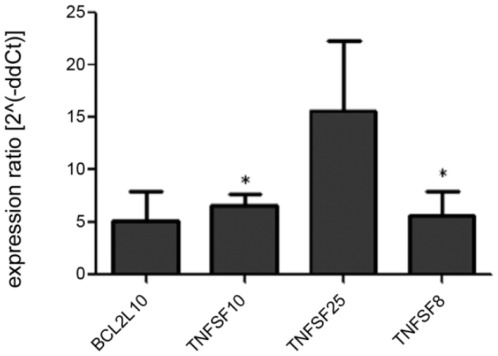
RNAi of DPP3 (siDPP3) inhibits influenza replication by modulation of apoptotic genes.A549 cells were reverse transfected with 50 nM of siDPP3 or siNEG. After 48 hours, cells were infected with A/WSN/33 at an MOI of 0.001. After 18 hours of infection, cellular RNA was isolated and apoptosis gene expression profiles were determined by array. Gene expression was normalized to GAPDH levels. Silencing DPP3 resulted in upregulated levels of the pro-apoptotic genes BCL2L10, TNFSF10, TNFSF25 and TNFSF8. Data is representative of three independent experiments. * p<0.05.